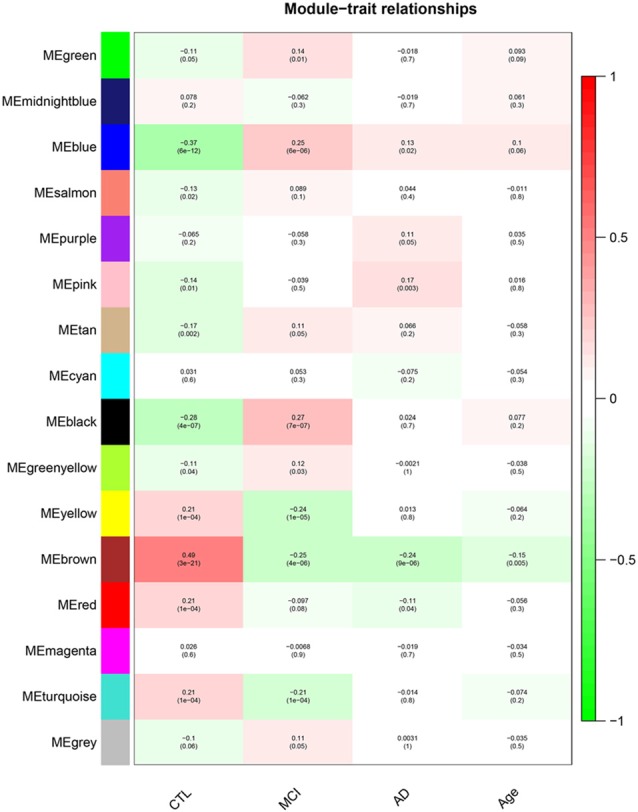
Module–Trait relationships. Correlation between module eigengene (ME) expression levels and control subjects (CTL), mild cognitive impairment (MCI), Alzheimer’s disease (AD) and Age in each module. Pearson correlation is reported with the p-value given inside the bracket.